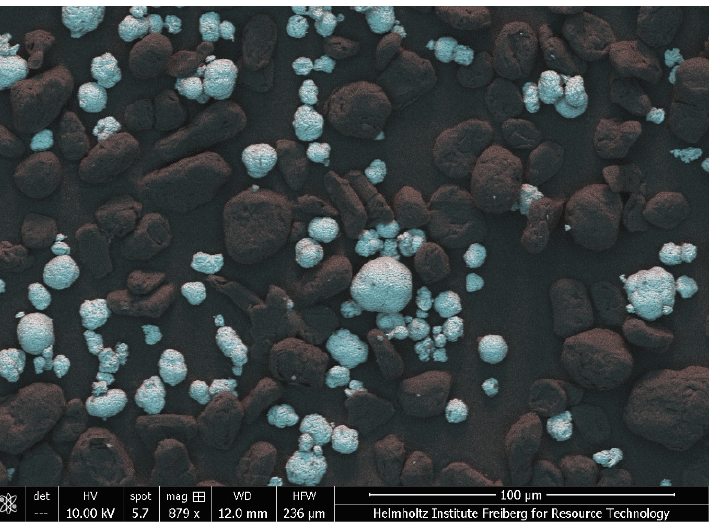
Figure 5. SEM image with imposed colors of the model black mass before attrition. LMO particles in blue and graphite particles in black. blue and graphite particles in